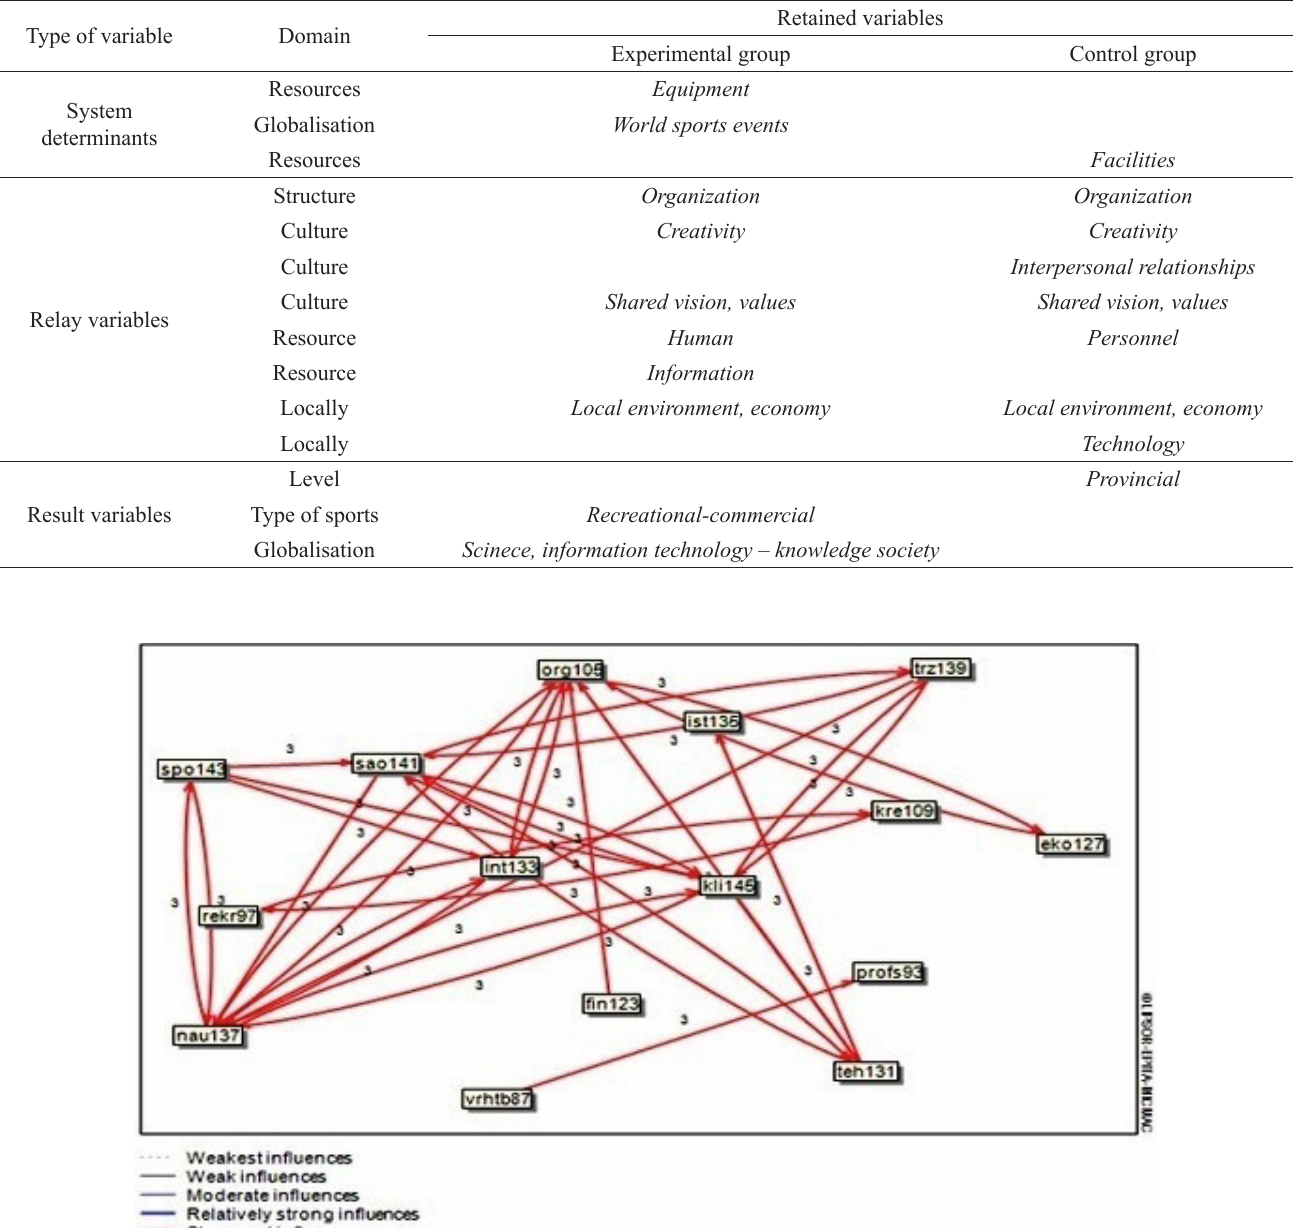
vrhtb87 - Top of the